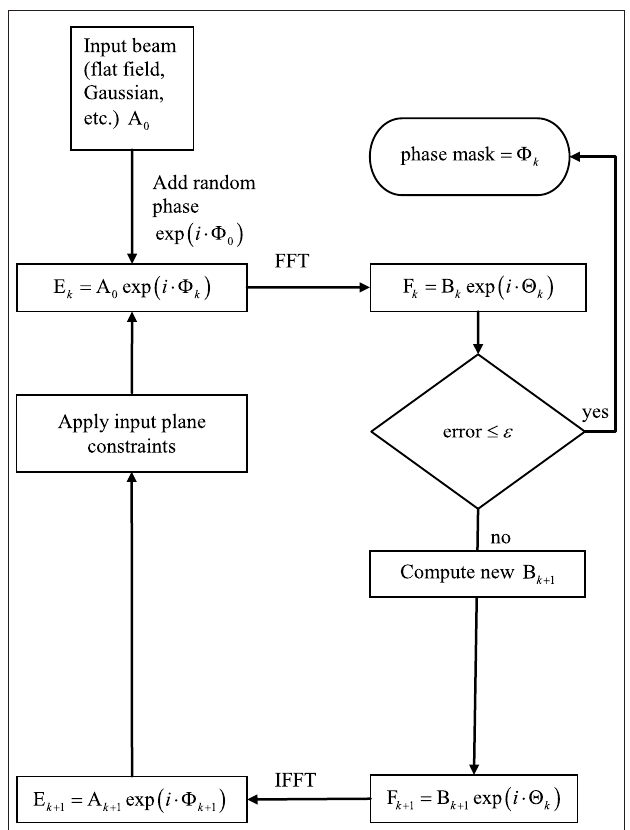
FIGURE 2 | SLM phase mask formation. Block diagram of the phase mask algorithm, described in more detail in section “Materials and